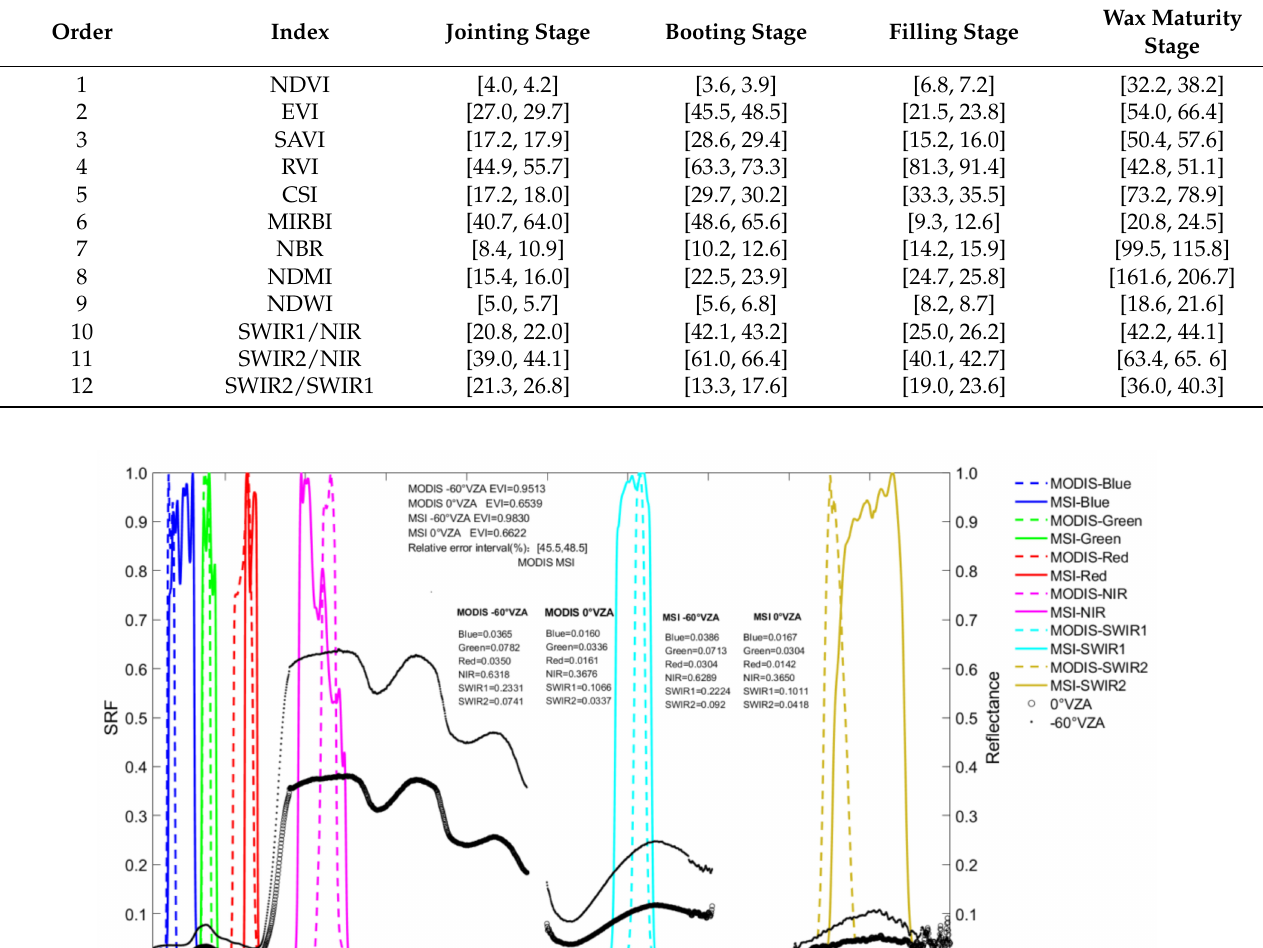
Table 7. Maximum relative difference intervals of indices (%) calculated based on the simulated value.